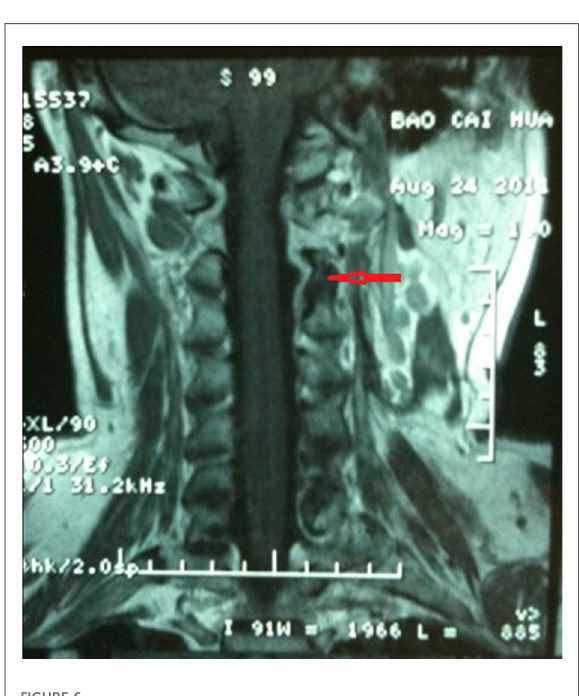
FIGURE 6 MRIs of the postoperative cervical